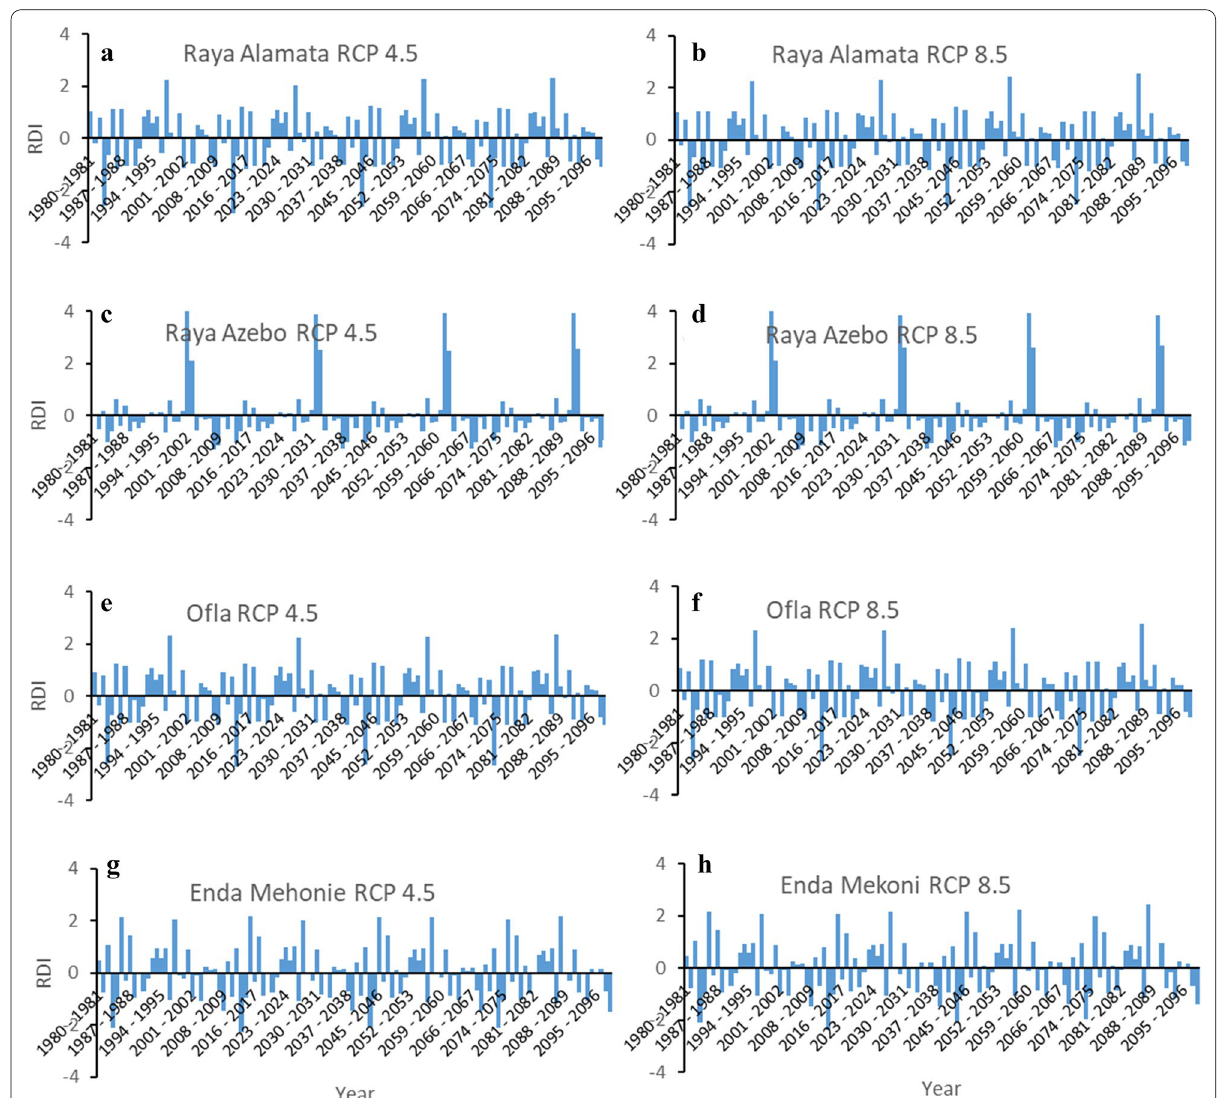
Fig. 2 RDI value calculation from observed (1980–2009) and projected rainfall and temperature data at Raya Alamata ( a , b ), Raya Azebo ( c , d ), Ofla ( e , f ), and Enda Mekoni ( g , h ) district during in 2021–2099 under RCP 4.5 and RCP 8.5 emission